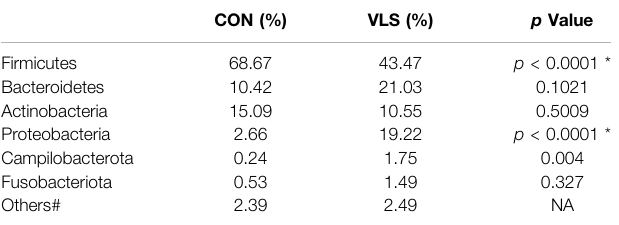
TABLE 3 | The mean relative abundance of microbiota at phylum level in the VLS group and control group.